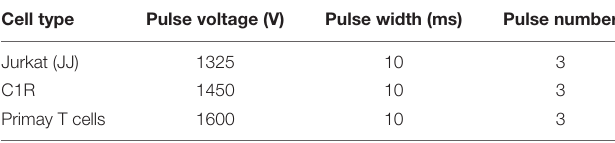
TABLE 3 | Electroporation conditions used for CRISPR-Cas9 system transfection.